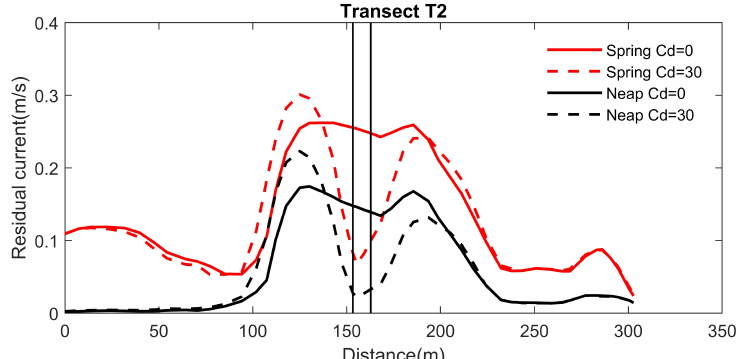
Figure 10. Residual current at cross transect T2 (the SND is located at a distance of 153 m correspond- ing the reduction zone in velocities indicating by vertical black